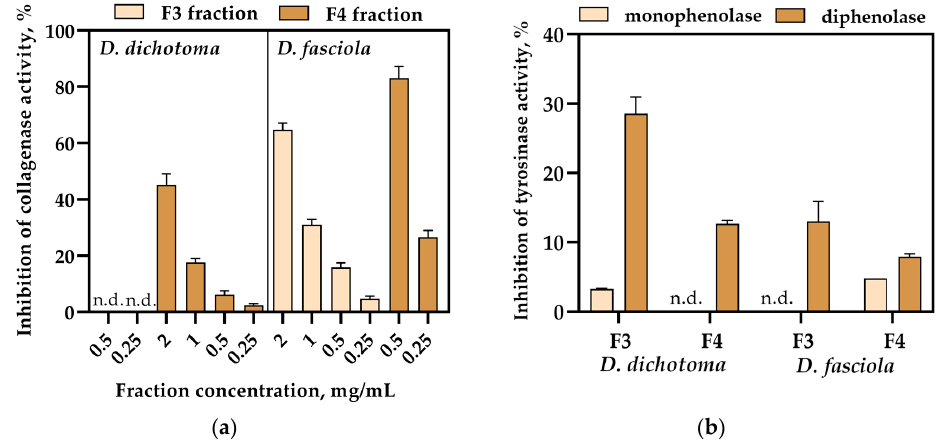
Figure 4. Enzymatic activity of D. dichotoma and D. fasciola fractions evaluated as ( a ) collagenase inhibitory potential at di ff erent concentrations of samples and ( b ) tyrosinase inhibition percentage at the concentration of 0.250 mg/mL for all fractions. Data are expressed as the means ± SD of three independent experiments. n.d. = not detected. Tyrosinase inhibitory activity or inhibition of enzymatic browning was evaluated in response to two di ff erent substrates, L-tyrosine (monophenolase activity) and L-DOPA (diphenolase activity). Due to the organic solvents (methanol and DMSO) present in frac- tions F3 and F4, the highest possible tested concentration was 1% of both fractions, so IC 50 concentration could not be achieved. Algae samples were tested at the concentration of 250 µg/mL and the results are shown in Figure 4b. As can be seen, a rather low inhibition percentage was obtained for both D. dichotoma and D. fasciola . Similar monophenolase ac- tivity was observed for D. dichotoma F3 (3.28 ± 0.06%) and D. fasciola F4 (4.81 ± 0.01%)